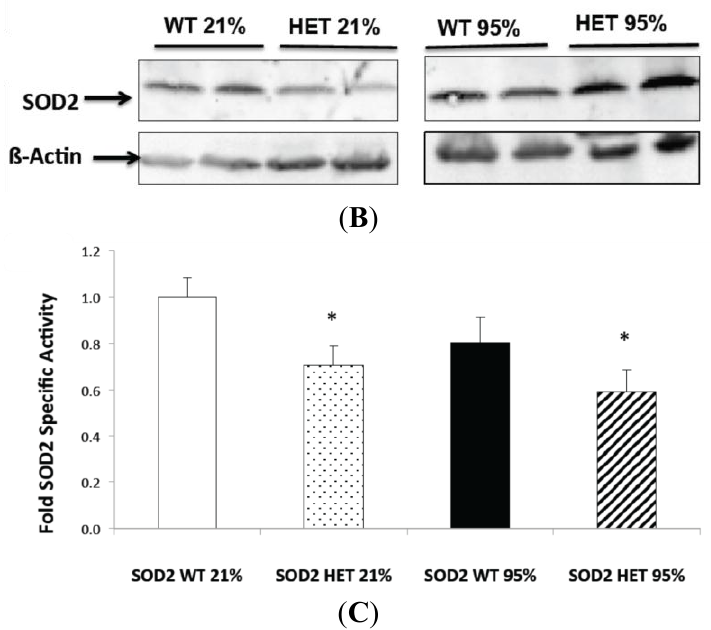
Figure 2. Hyperoxia increased SOD2 protein expression but not activity in pulmonary artery smooth muscle cells (PASMC) from SOD2−/+ and SOD2+/+ mice. ( A ) PASMC were isolated from both SOD2−/+ (HET) and SOD2+/+ (wild-type, WT) mice. PASMC were exposed to hyperoxia (95% O 2 ) for 24 h. SOD2 expression was measured by Western blot in lysates from WT and HET PASMC ( n = 6 for WT PASMC and n = 10 for HET PASMC) in both room air and hyperoxia (* p < 0.05 vs. SOD2 WT in 21% O 2 ). Data are shown as mean ± SEM; ( B ) Representative Western blots of SOD2 expression are shown with corresponding β-actin; and ( C ) PASMC from HET and WT mice were assayed for SOD2 activity using a commercially available activity assay ( n = 14 for WT PASMC in 21% O 2 and n = 12 for all other groups; * p < 0.05 vs. SOD2 WT in 21% O 2 ). Data are shown as mean ±